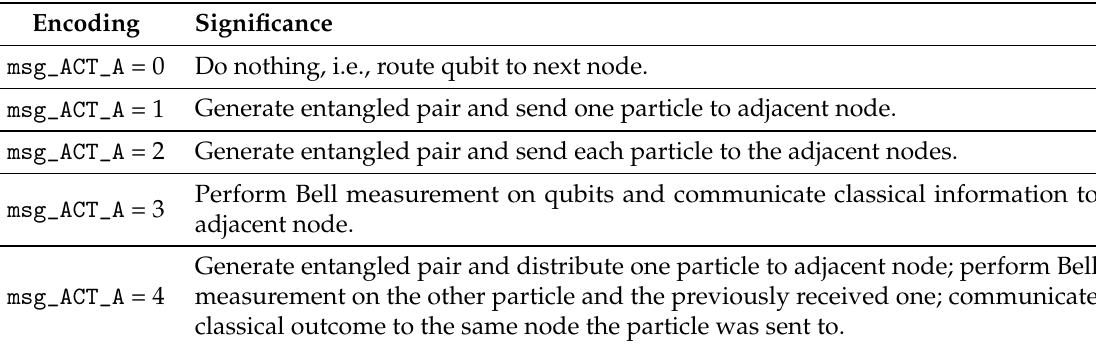
Table 1. Classical instruction messages sent by Alice to her known quantum switches and to Bob.